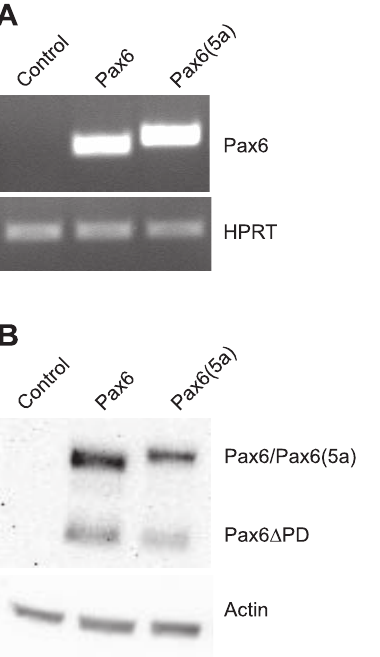
Figure 1. RT-PCR and Western blot confirm expression of the correct Pax6 isoform in the FlpIn-3T3 Pax6 and Pax6(5a) cell lines. (A) RT-PCR primers were designed so that the alternatively spliced exon 5a (42 bp) would be included in the PCR product if present. HPRT specific primers were used to show equal input of cDNA. Neither Pax6 nor Pax6(5a) is present in the FlpIn-3T3 control cell line. (B) Western blot with a Pax6 specific antibody (Millipore # AB2237) confirms expression of Pax6 and Pax6(5a) proteins in the respective cell lines. The lower molecular weight band of equal size for each of the Pax6 cell lines is the Pax6 D PD isoform generated from an internal AUG startcodon in the link between the paired domain and the homeodo-